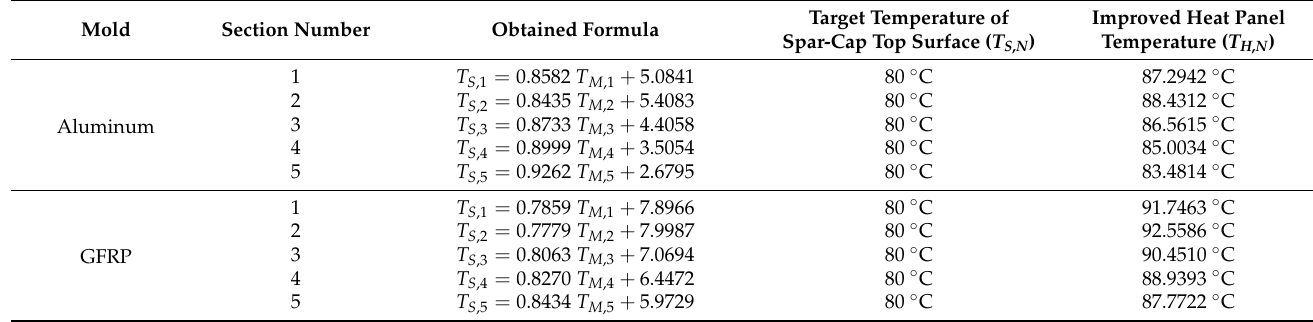
Table 4. Heat panel temperature by section to which obtained formula is